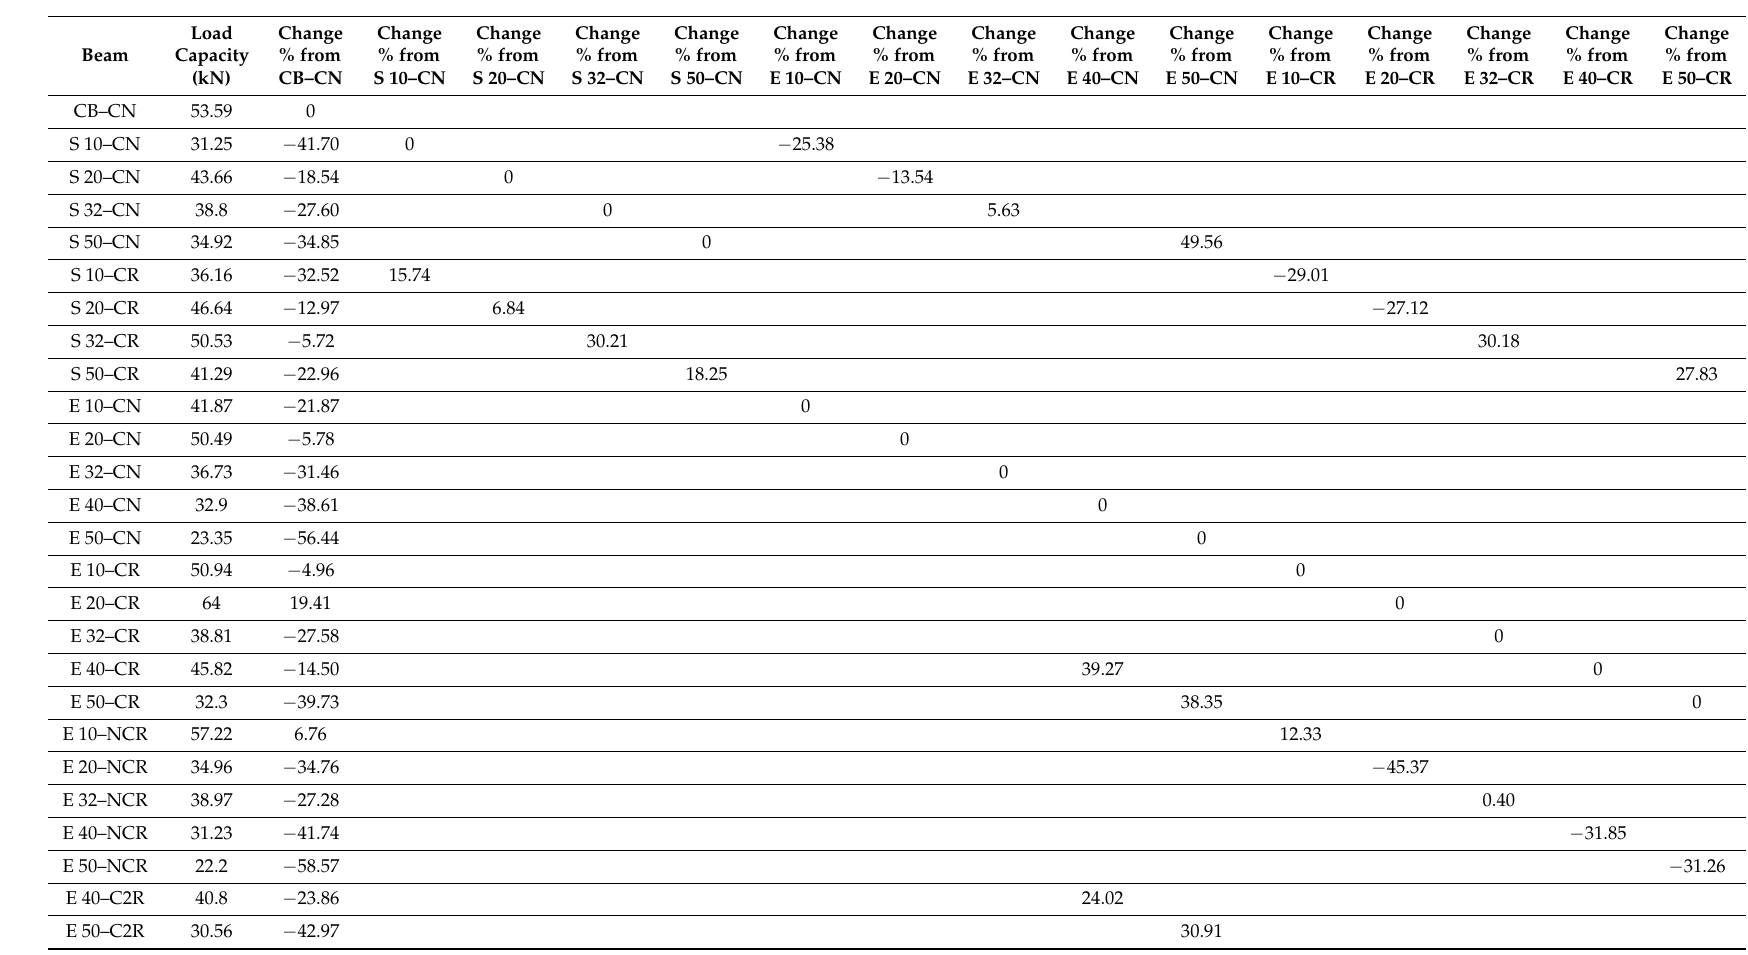
Table 6. Comparison between load capacity of all